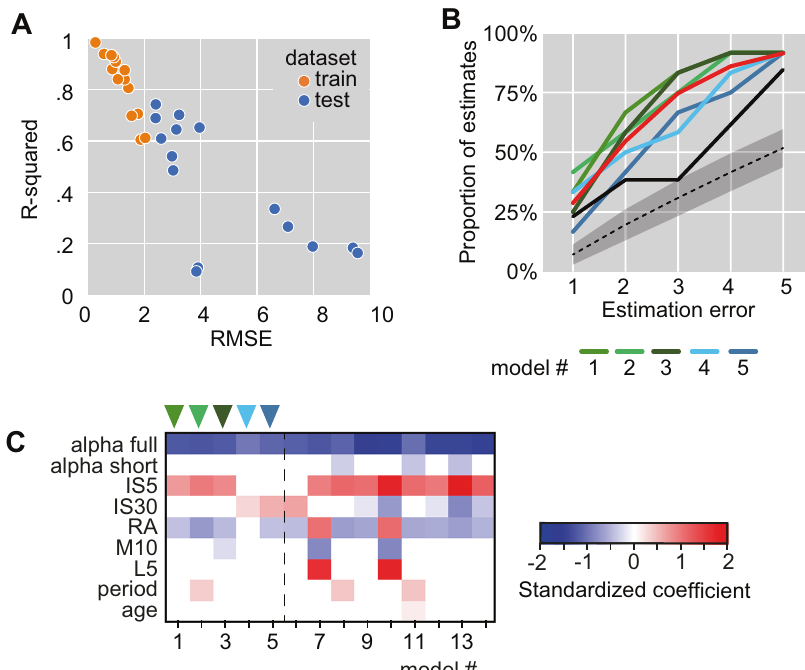
Fig. 3 Development of multiple regression models using forward stepwise approach. A A total of 14 models forward stepwise multiple regression models survived external validation and were used for further analyses. The performance of selected models in predicting the depression score in the test dataset is displayed on the same axes for comparison with the performance on training dataset. B Evaluation of prediction of MADRS score at individual level for the selected models as compared to dummy model (constant output equal to the average of the sample; solid black line) and random prediction (dashed black line and shaded areas depict mean and 95% con fi dence intervals estimated over 1 million simulated datasets). The red line depicts the average performance of validated models developed by brute force. Line colors correspond to arrowhead colors in ( C ). C Leverage of individual predictors as illustrated by standardized coef fi cients. Models to the right of the vertical dotted line did not survive external validation. Models #1, 3, and 5 are further analyzed in Fig.